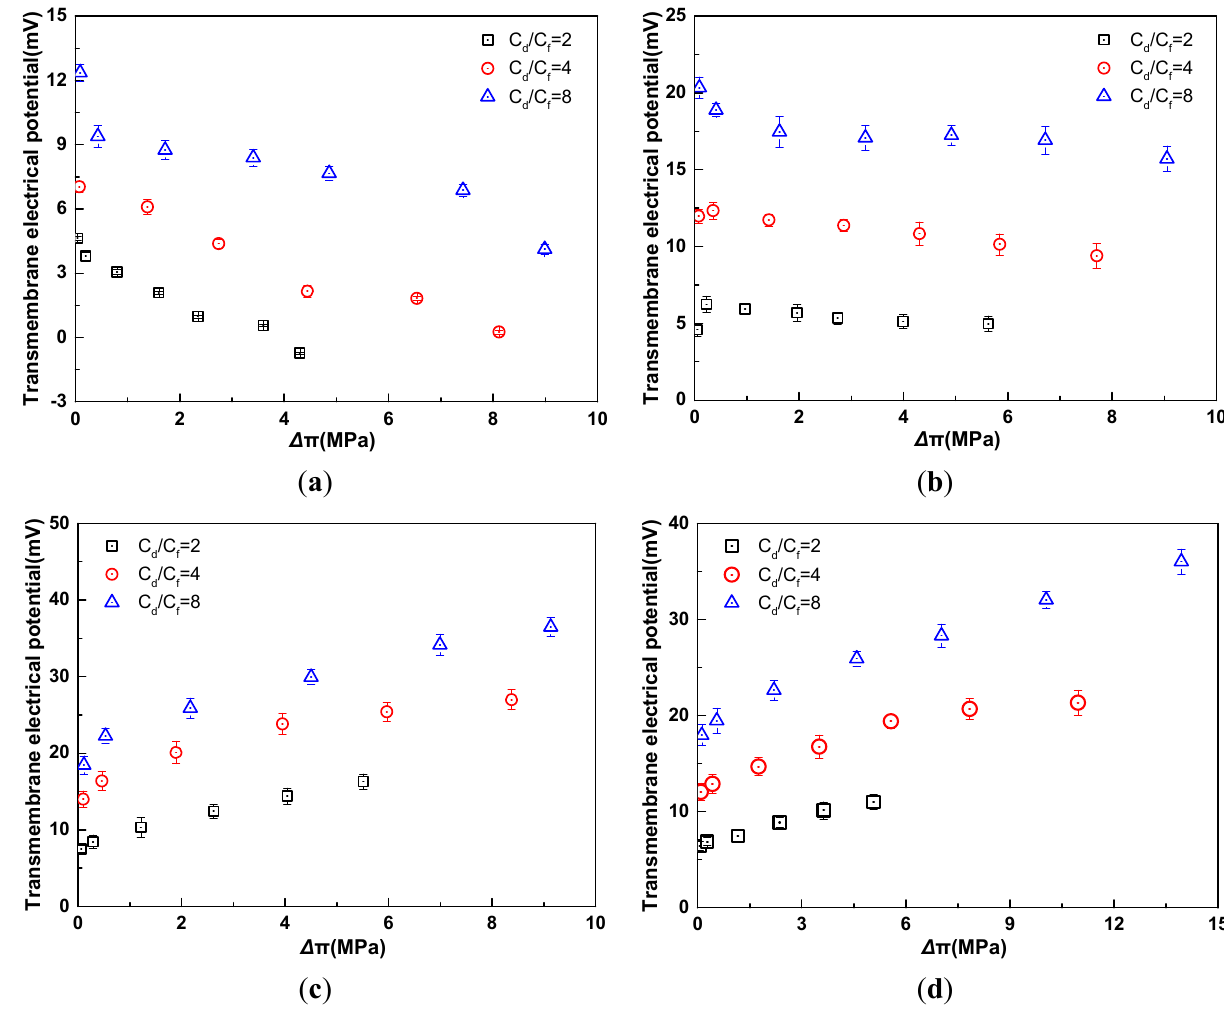
Figure 4. Relationship of transmembrane electrical potential and osmotic pressure difference with different ratio of feed concentration and draw concentration in AL-DS mode( t = 25 °C). ( a ) KCl; ( b ) NaCl; ( c ) MgCl refers to the effective values after correction for the effect of